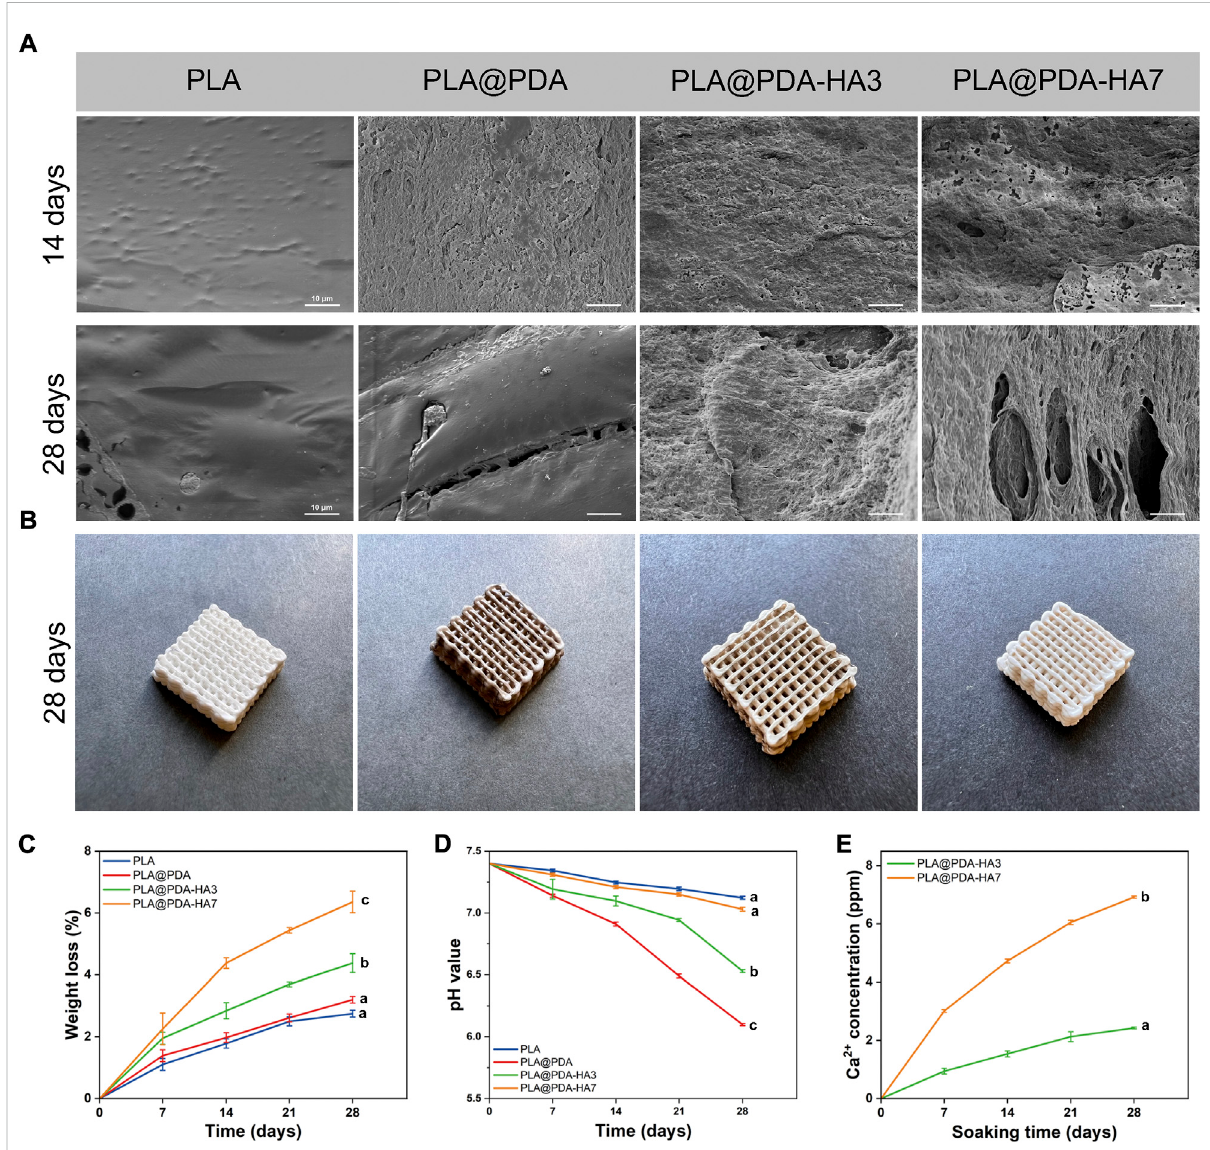
FIGURE 8 In-vitro degradation behavior of PLA, PLA@PDA, PLA@PDA-HA3, and PLA@PDA-HA7 scaffolds after immersing in PBS for 28 days. (A) SEM images ofsurfacemorphologyofeach scaffold after soakinginPBS for14 and28 days; (B) Representative opticalphotographs ofeach scaffold after 28 days of immersing; (C) Weight loss ratio of each scaffold for 28 days of degradation; (D) pH variation of immersing solution for 28 days; (E) 28 days ’ Ca 2+ release pro fi le of PLA@PDA-HA3 and PLA@PDA-HA7